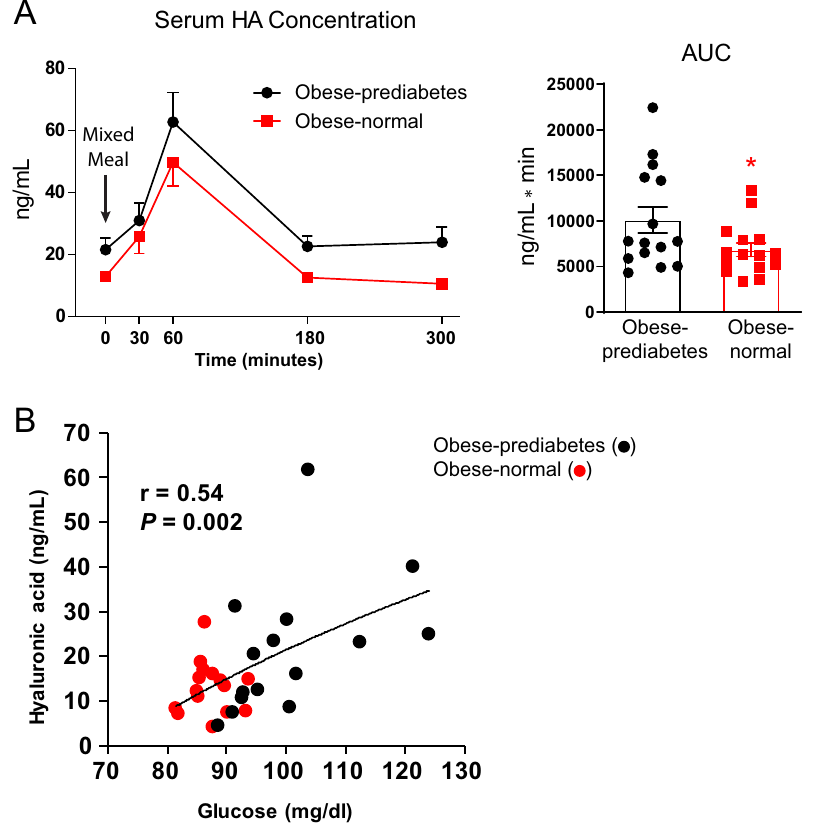
Fig. 1 Circulating HA inversely correlates with metabolic fi tness in the human. A Obese-prediabetes (Obese-prediabetes; n = 15 patients) patients have higher levels of circulating HA compared to obese-normal (Obese-normal; n = 15 patients) patients. Subjects ingested a mixed meal at the indicated time point. Mean± s.e.m; For AUC, two-tailed t -test, p = 0.0499. *indicates p ≤ 0.05. B Plasma HA concentrations ( t = 0 ’ ) were directly correlated with basal plasma glucose concentrations. Logarithmic regression analysis was used to determine the line of best fi t to the